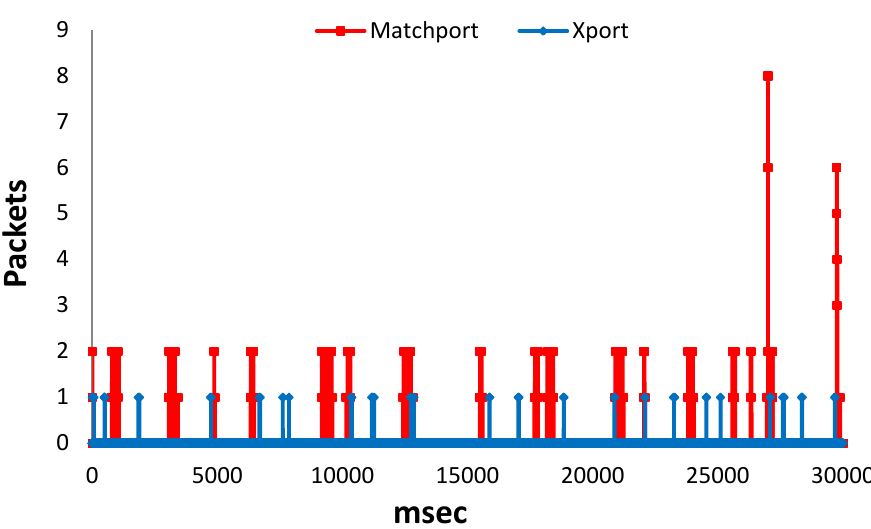
Figure 17. Packets received per millisecond in active